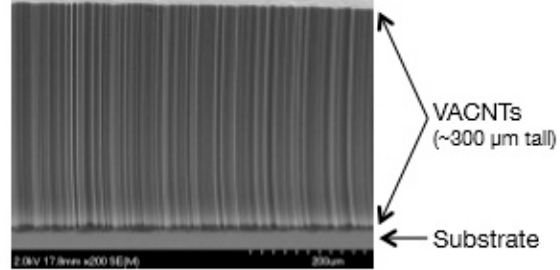
Figure 2. Vertically aligned Carbon Nanotube “Forest” under an electron microscope, forest height 300 μ m [9].